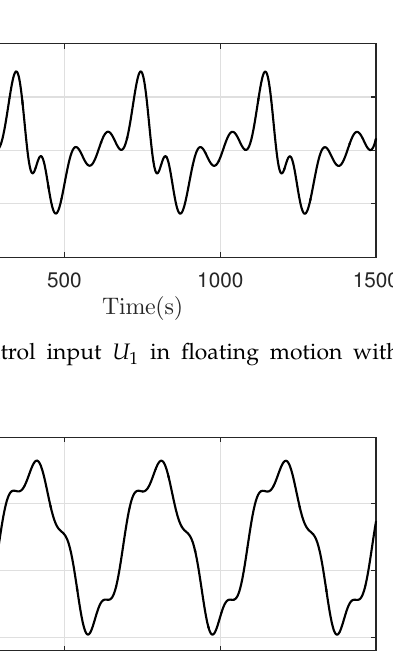
Figure 25. Pitch angle tracking error in floating motion with a constant velocity and variable pitch angle command.